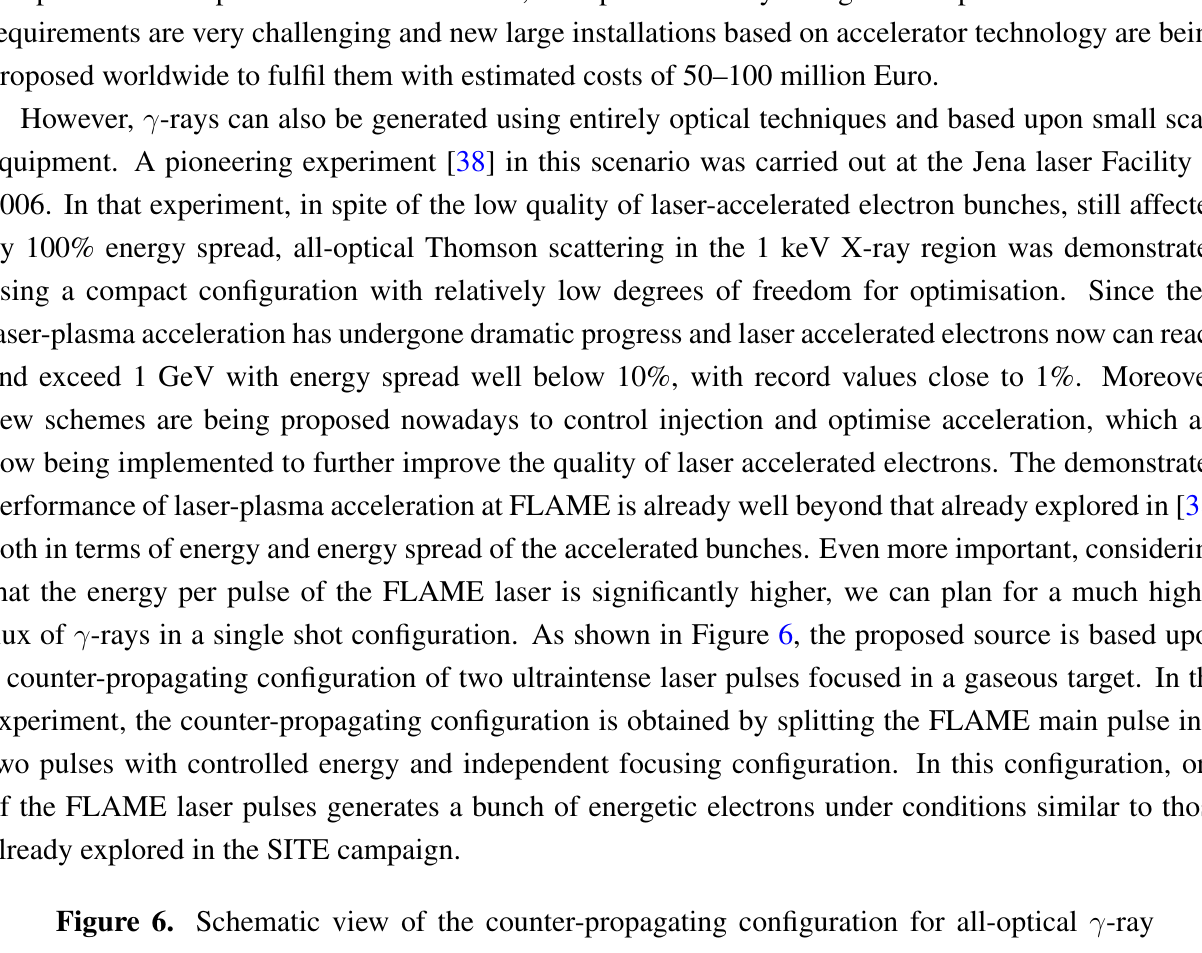
Figure 6. Schematic view of the counter-propagating configuration for all-optical γ -ray generation. The main FLAME laser pulse is split in two pulses that are focused in the proximity of a gas target. One of the two pulses (right) accelerates electrons using the SITE15 configuration. The other pulse is focused on the accelerated electron bunch to scatter off γ -rays that are emitted along the electron bunch propagation